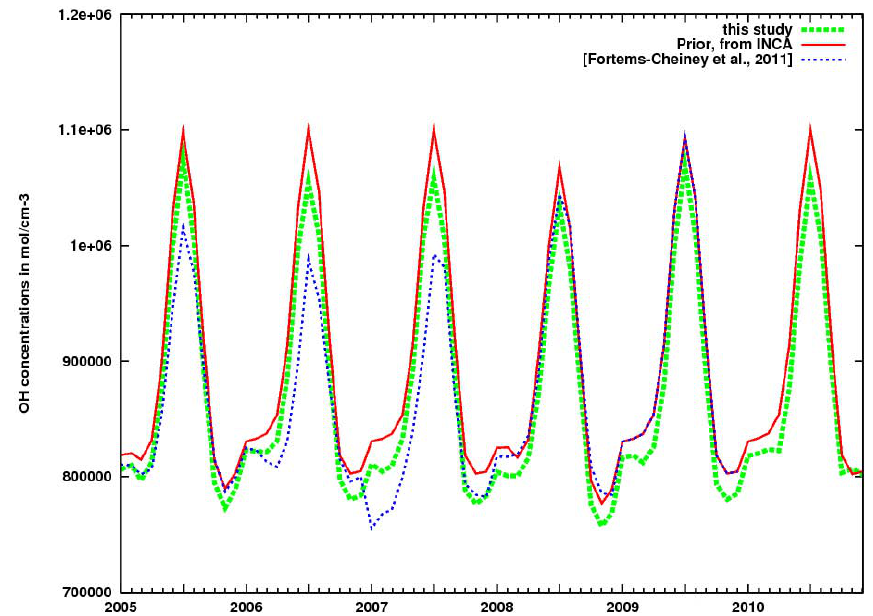
Fig. 7. Seasonal cycle of the global tropospheric mean of OH prior concentrations from LMDz-INCA (in red), OH posterior concentrations using only MOPITT as constraints from Fortems-Cheiney et al. (2011) (in blue) and OH posterior concentrations using OMI, MOPITT and surface stations (this study, in green), from January 2005 to December 2010. Units are molcm − 3 .